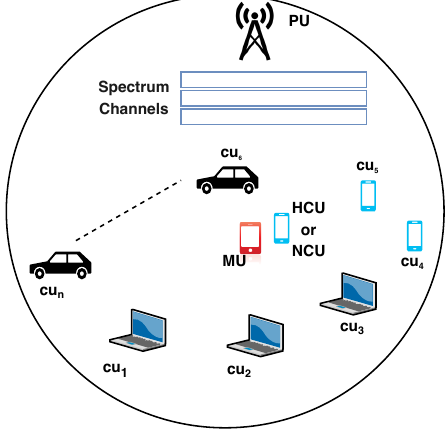
Figure 1. The CU (Cognitive Users) handoff mechanism for a cognitive radio network